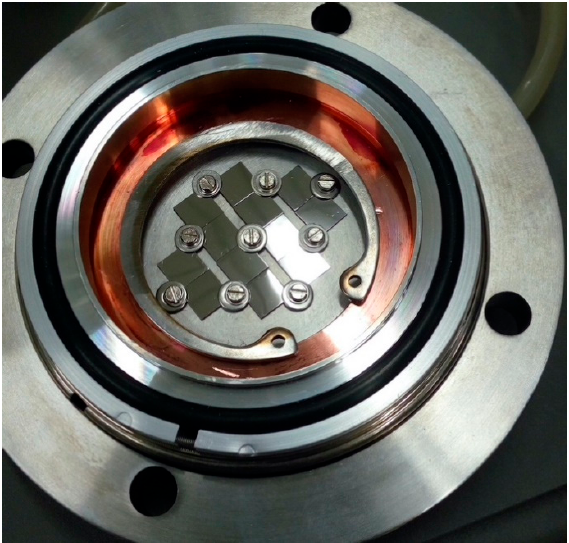
Figure 3. Design of a sample holder for helium implantation experiment at 6 MV Tandetron ion accelerator at STU.